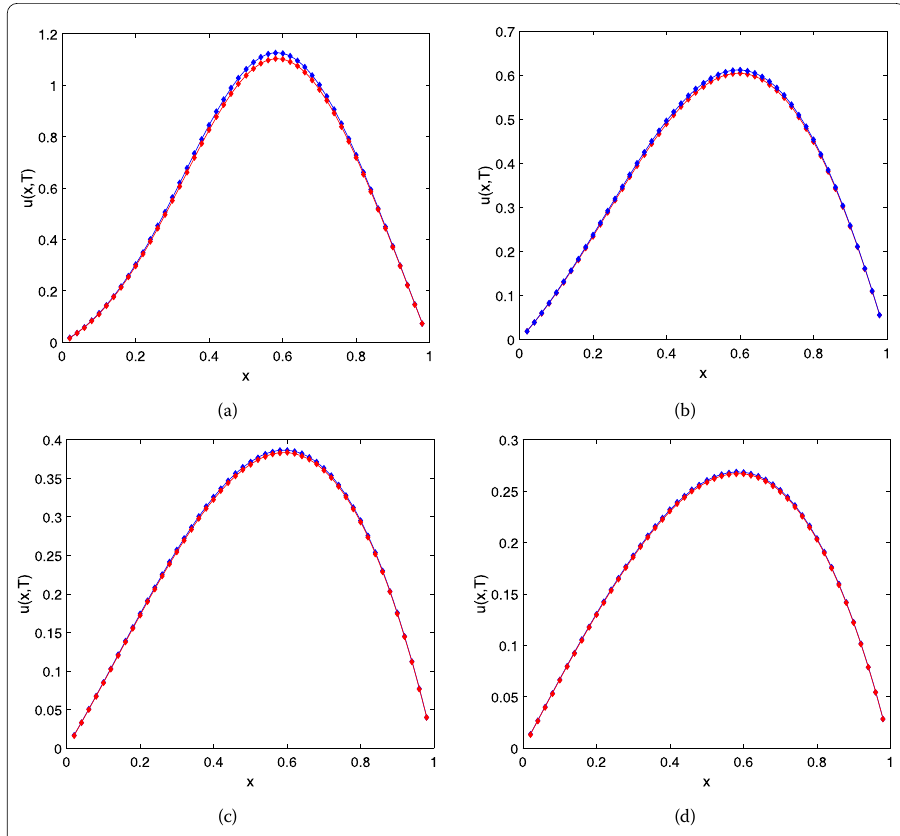
Figure 4 Numerical solutions of Example 5.2 at α = 0.5, q = 15, M = 50, N = 20, and T = 5 with different β and ω ( α ). ω ( α ) = τ α (red); ω ( α ) = δ ( α – 0.5)